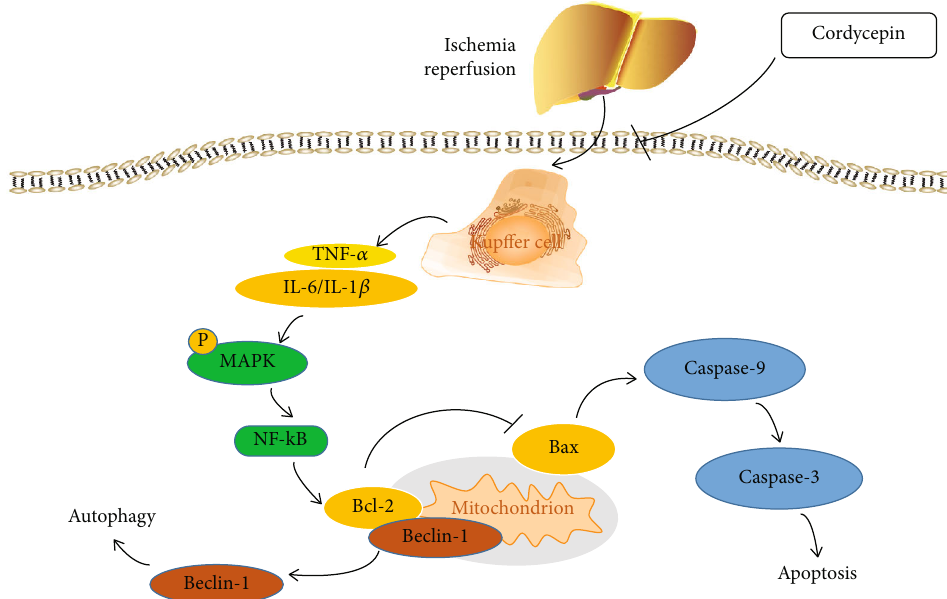
Figure 6: Possible mechanism of cordycepin in hepatic ischemia-reperfusion injury. In IR model, activated Kup ff er cells promote the release of proin fl ammatory cytokines such as TNF- α , IL-1 β , and IL-6, and cordycepin reduces in fl ammatory cytokines. In addition, cordycepin inhibited the phosphorylation of MAPK, which then reduce the expression of NF- κ B to e ff ect hepatocyte apoptosis and autophagy. Cordycepin has a protective e ff ect on ischemia-reperfusion liver by inhibiting in fl ammation and attenuating apoptosis and autophagy through the MAPK/NF- κ B